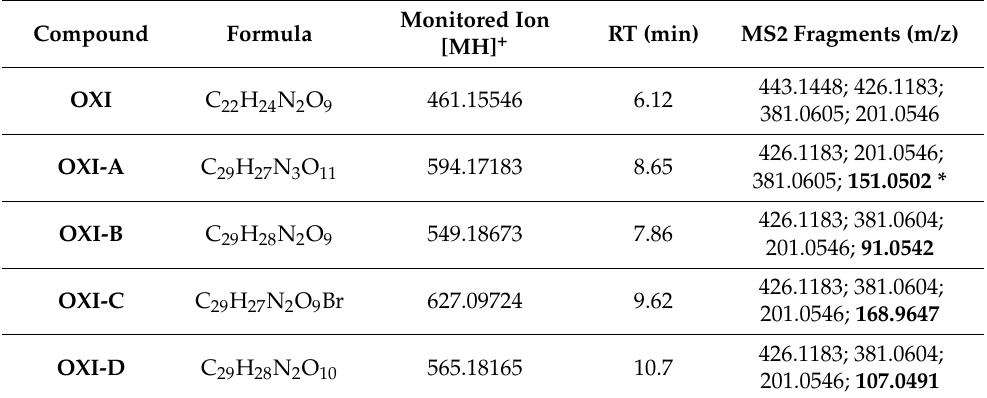
Table 1. Target compounds, protonated precursors and fragment ions for oxytetracycline and derivate compounds.